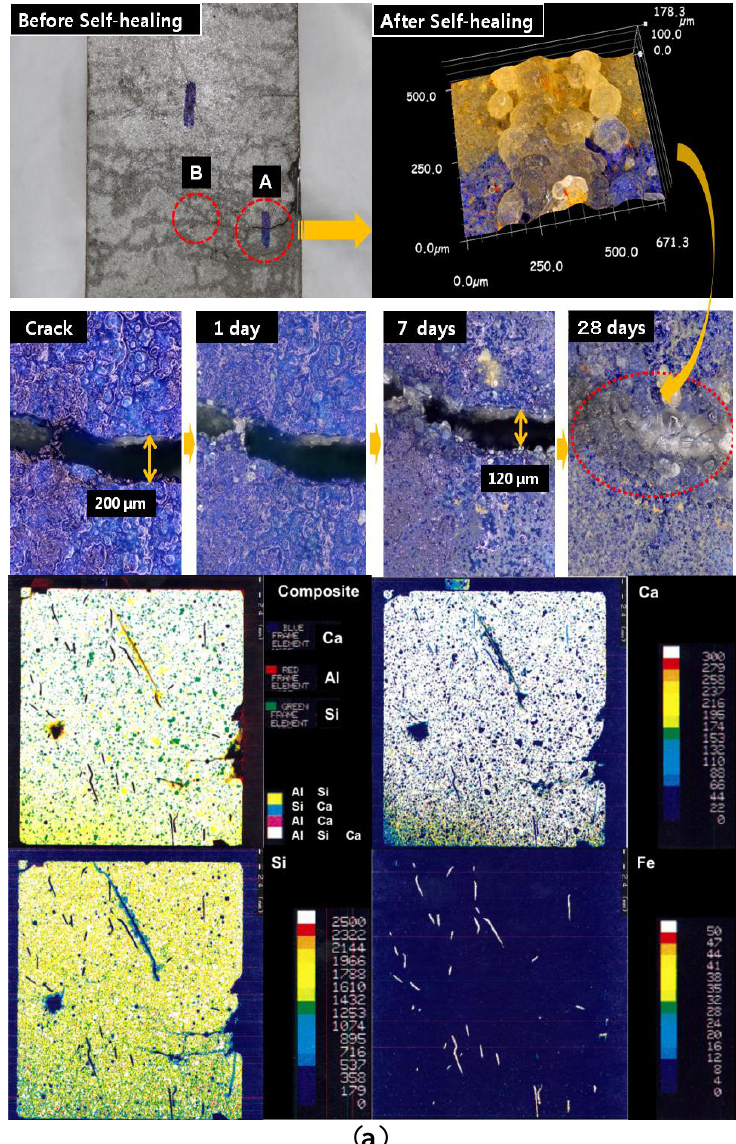
Figure 9. Process of self-healing in matrix A with 2% hooked fiber. ( a ) Zone A with 200-µm crack width (electron probe microanalysis (EPMA) after self-healing); ( b ) Zone B with 130-µm crack width (EPMA after